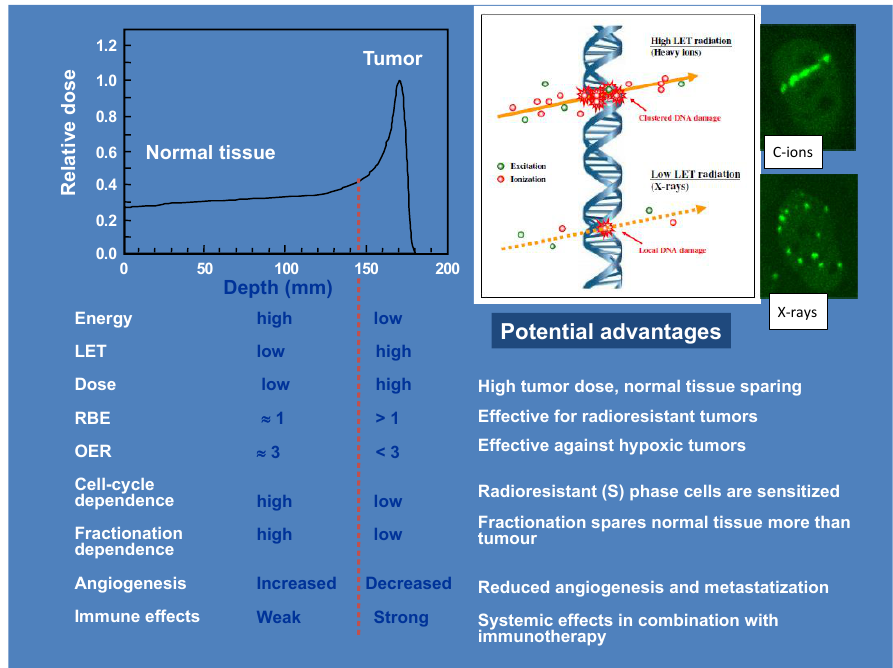
Figure 2. Summary of the physical and radiobiological properties of heavy ions along the Bragg curve. The figures on top right show a sketch of the quality of DNA damage and the corresponding γ H2AX foci distribution with carbon ions and X-rays. Adapted from [12].